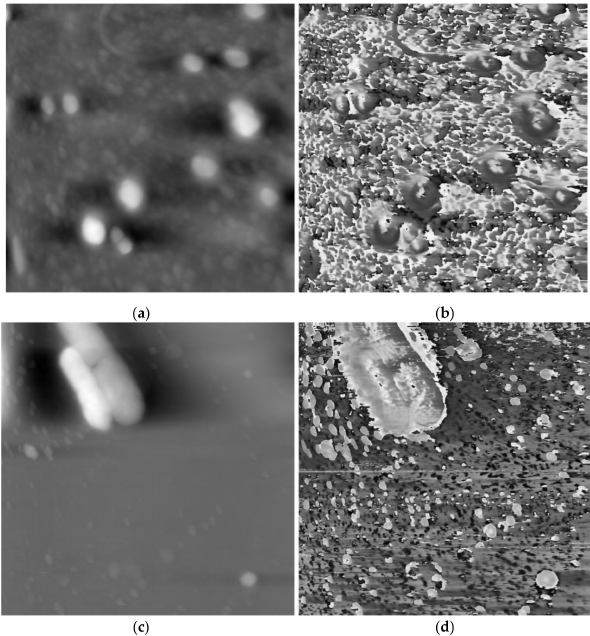
Figure 4. Di ff erent scan results of atomic force acoustic microscopy (AFAM) in our experiments. ( a ) morphology image of scan 1; ( b ) phase image of scan 1; ( c ) morphology image of scan 2; ( d ) phase image of scan